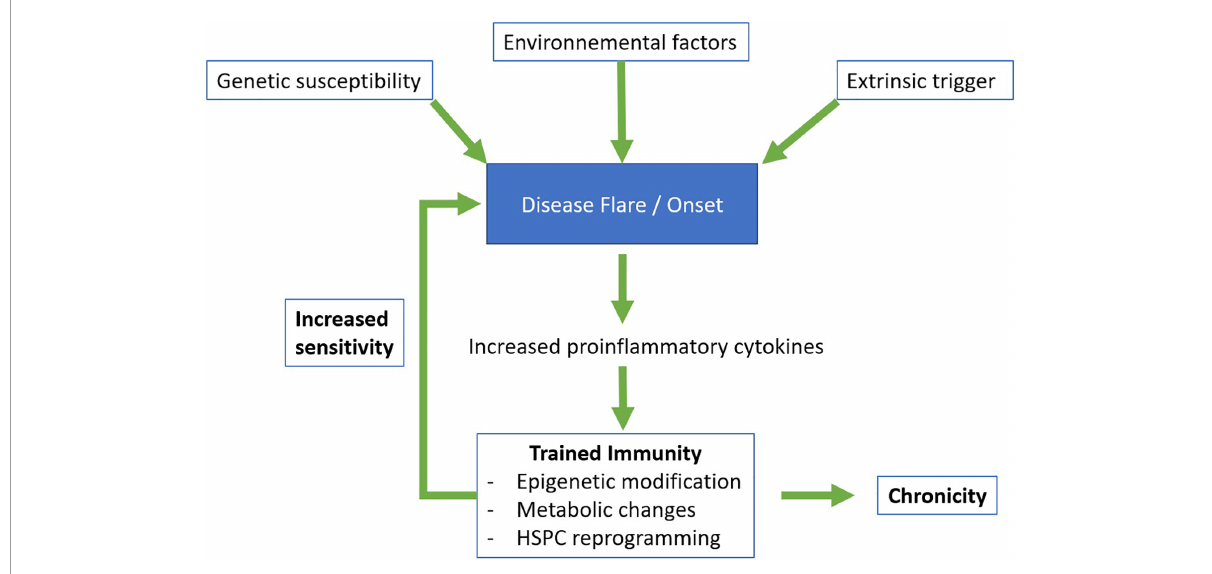
FIGURE2 Proposed model for the involvement of trained immunity in autoinflammatory and autoimmune diseases. HSPC, hematopoietic stem and progenitor